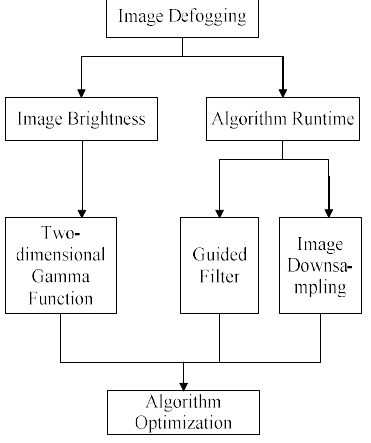
Figure 1. Algorithm optimization